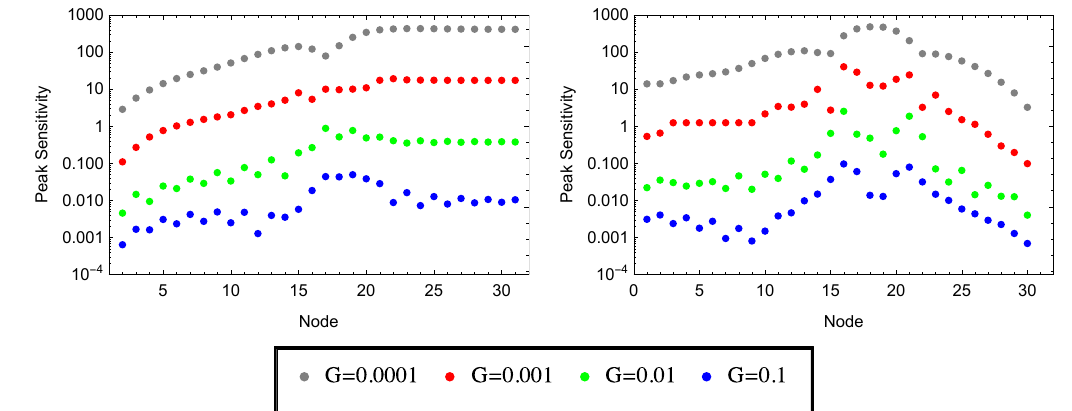
Figure 5. Peak elevation ( left panel ) and velocity ( right panel ) sensitivity to G for implicit runs on the seamount domain. Each dot denotes the peak elevation sensitivity value, for a given node, over the last day of a five day simulation. The color of the dot is based on the G value shown in the